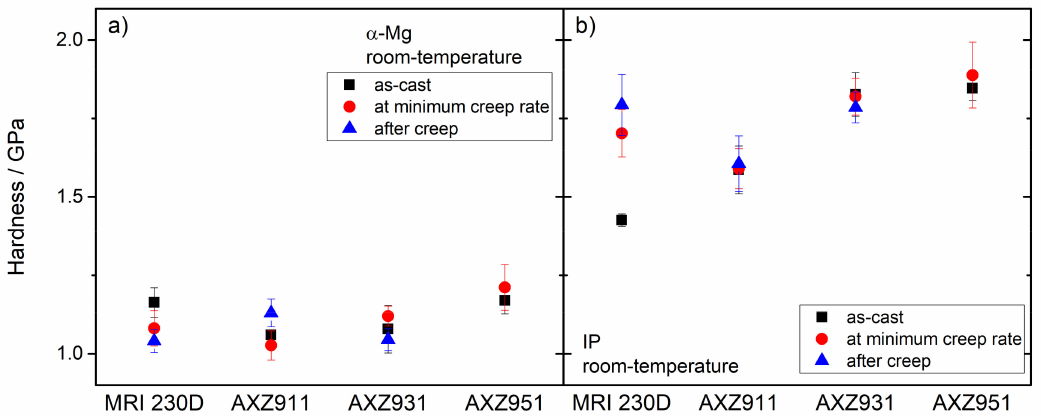
Figure 4. Room temperature hardness of the α -Mg ( a ) and the IP ( b ) for the different alloys measured at various